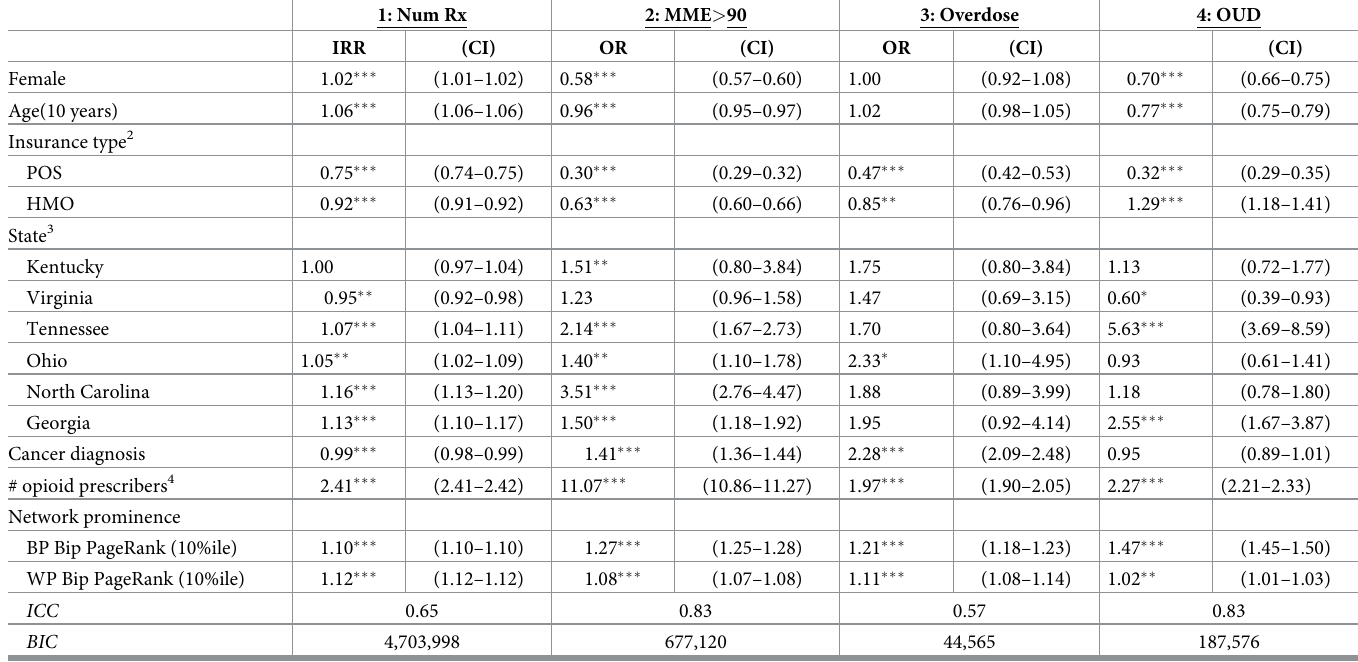
Table 4. Mixed effects regression 1 of opioid outcomes on between-person and within-person patient bipartite PageRank percentile and controls (n = 526,914; n obs =